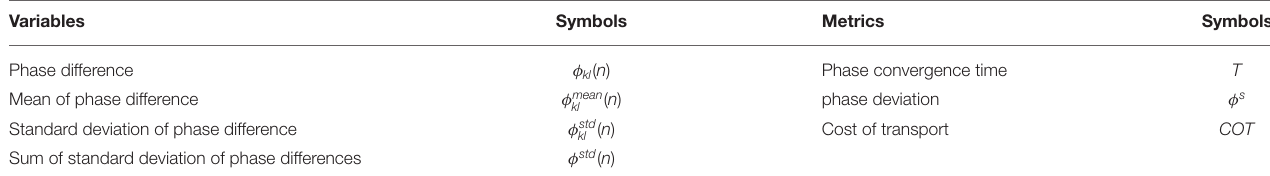
TABLE 1 | List of the variables and defined metrics.